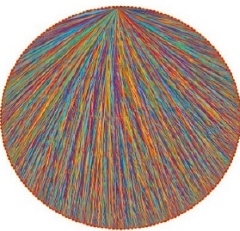
Figure 1. Network of relatives with small-world characteristics.